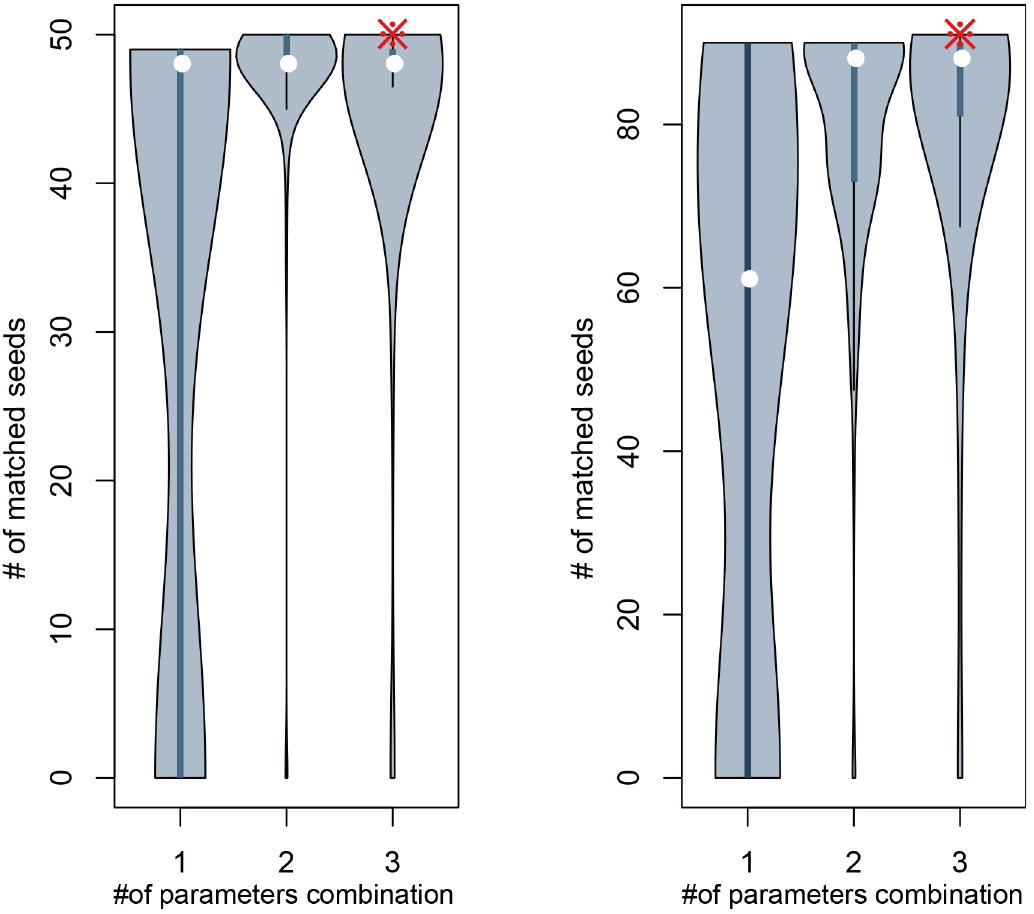
Fig 2. Violin plots of the number of matched seeds identified in top 50 and 100 of the ranking list. The number 1, 2 and 3 represent the number of parameter(s) in the parameter combinations, respectively. The asterisks and white circles present our results and the medians of each combination.